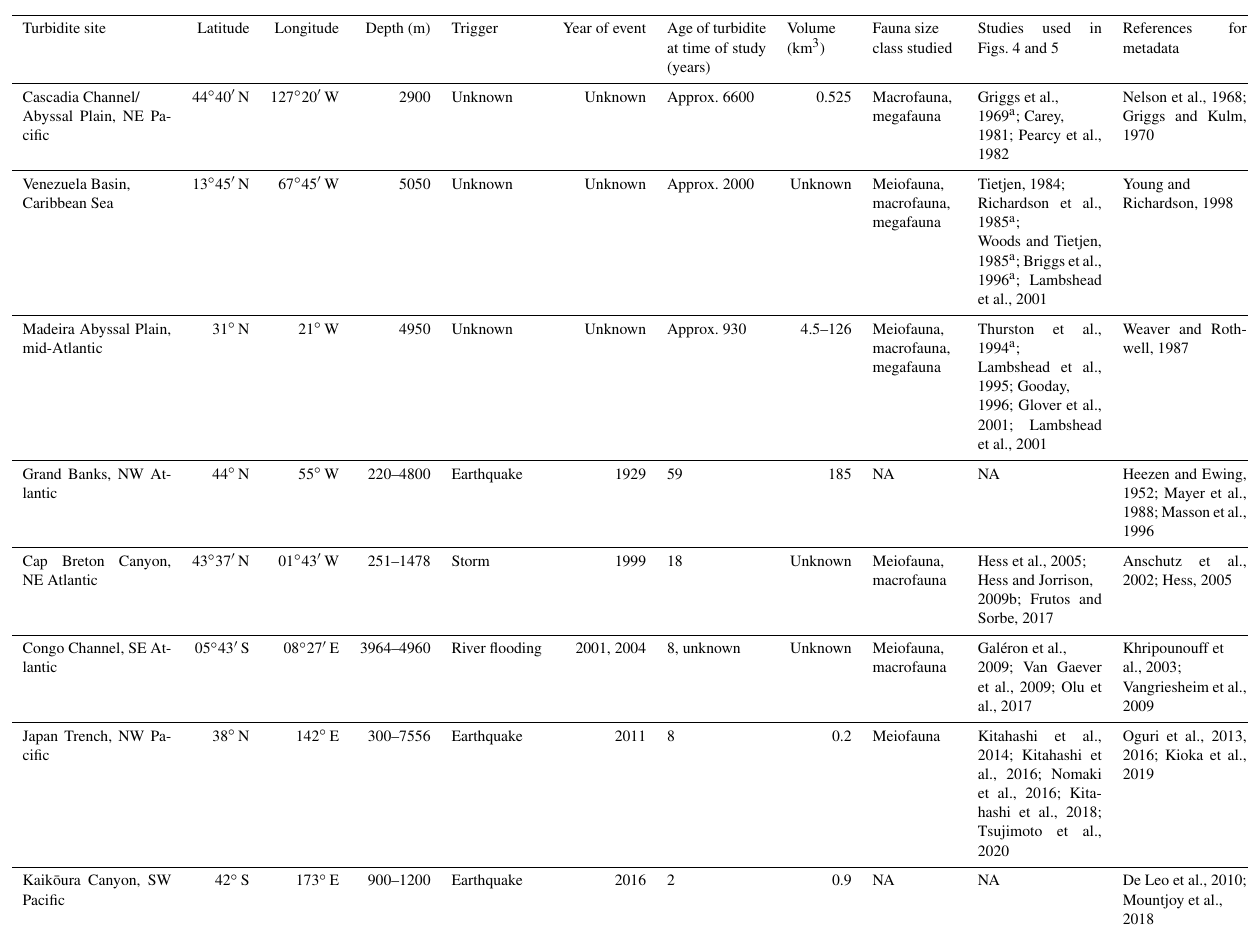
Table 1. Metadata for turbidites and studies discussed and analysed in this review. Turbidite